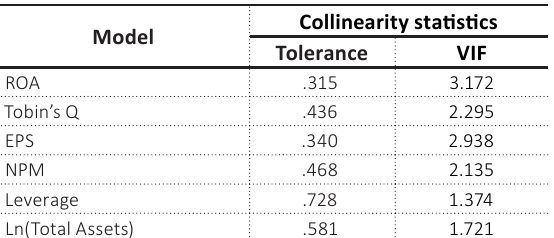
Table 4. Tolerance and Variance Inflation Factor (VIF) test